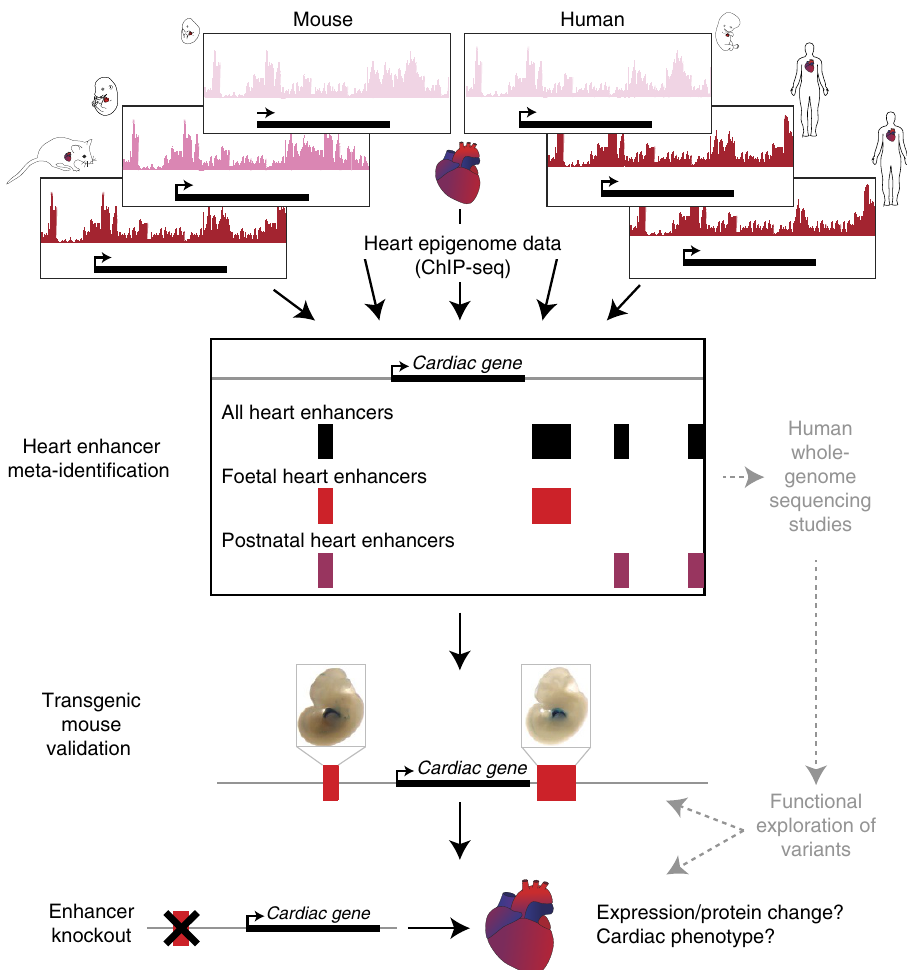
Figure 1 | Generation and validation of a genome-wide cardiac enhancer catalogue. Integrative analysis of 4 35 epigenomic data sets from ex vivo human and mouse heart tissue resulted in a catalogue of 4 80,000 putative human heart enhancers. We demonstrate the utility of this catalogue for the discovery of enhancers near heart disease-associated genes by characterizing the in vivo activity patterns of 22 novel cardiovascular enhancers in transgenic mouse assays. We also show the functional importance of enhancers by deleting two cardiac enhancers, which resulted in reduced gene expression and impaired cardiac